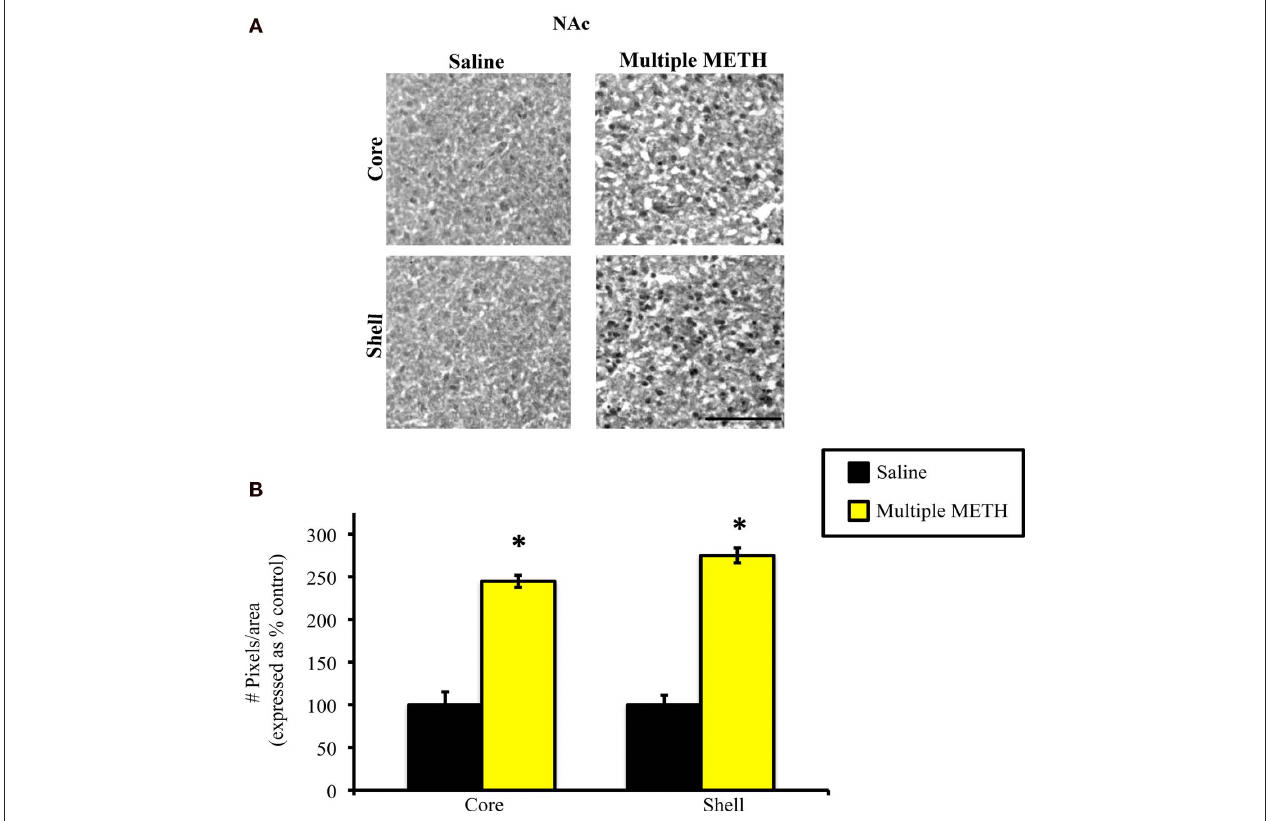
Figure 3 | Photomicrographs of MDA-ir in the core and shell of the NAc (A) , 1 week after saline or multiple MeTH treatment (4 × 10 mg/kg, s.c.). Scale bar represents 100 μM. Data are presented as the percentage of MDA-ir particles in saline-treated control animals ( ± SEM, n = 7–14 animals/group). Semi-quantitative analysis showed that treatment with multiple doses of METH significantly increased MDA-ir in both the core and shell of the NAc (B) . * p < 0.05 as compared to